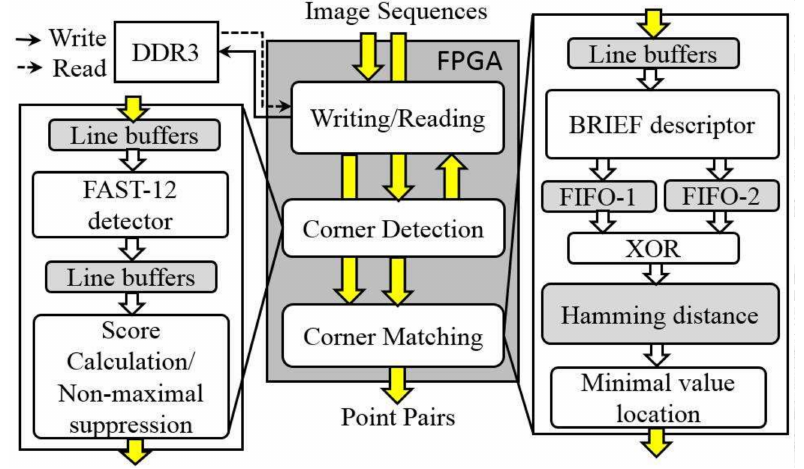
Figure 3. FPGA architecture of corner detection and